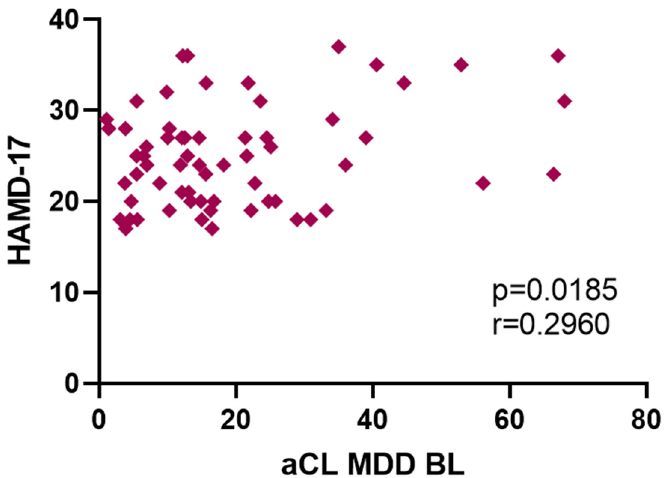
Figure 2. aCL IgM titers of all MDD patients in correlation with HAMD-17 at